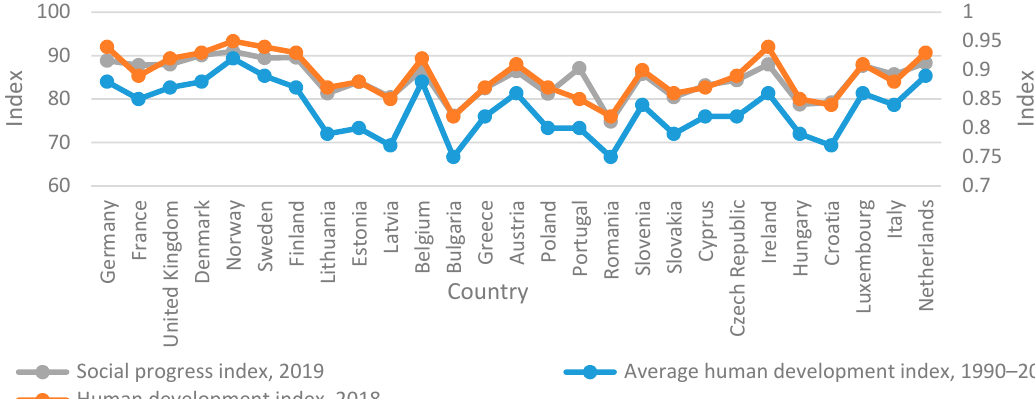
Figure 3. Social progress index, 2019, and HDI, 2018, and average HDI, 1990–2018, values in analysed countries.